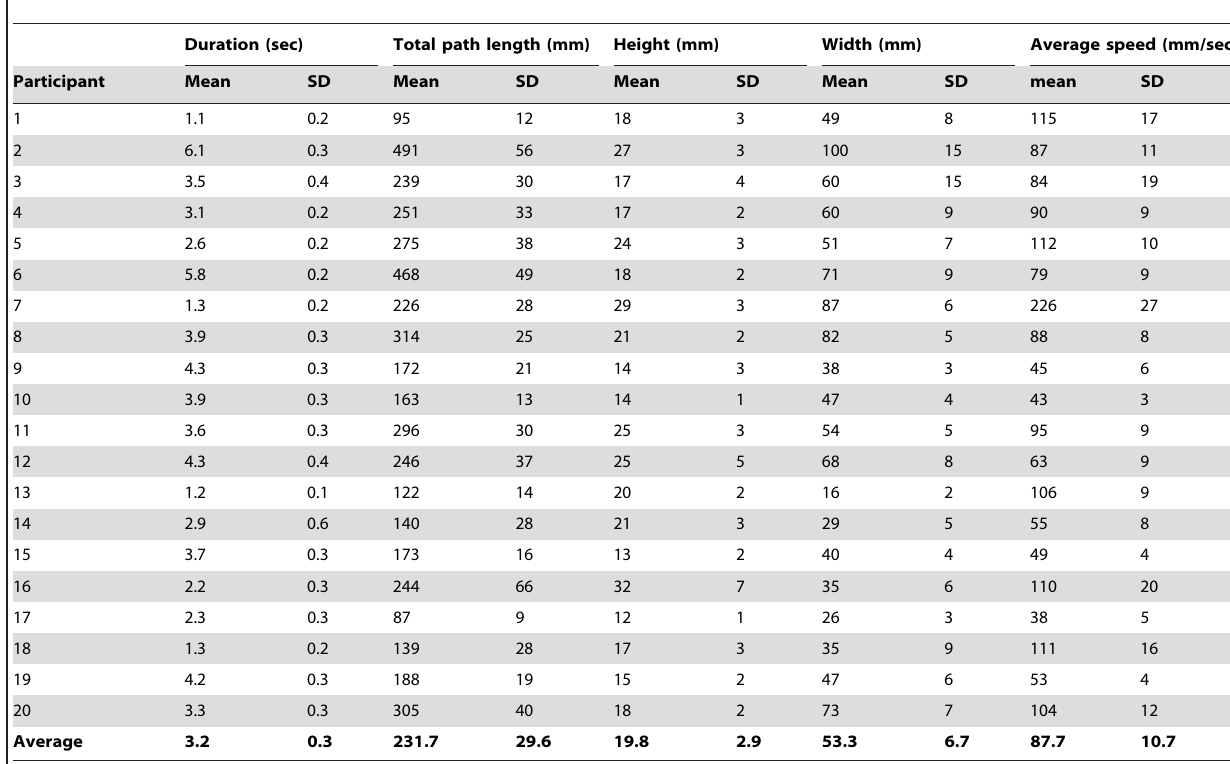
Table 1. Temporal, spatial and speed information of the authentic